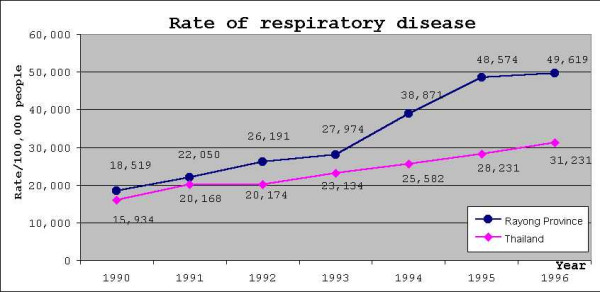
Rate of respiratory diseases in Thailand compared to Rayong province. Blue line indicates rates of respiratory disease of Rayong province. Magenta line indicates rates of respiratory disease of Thailand.